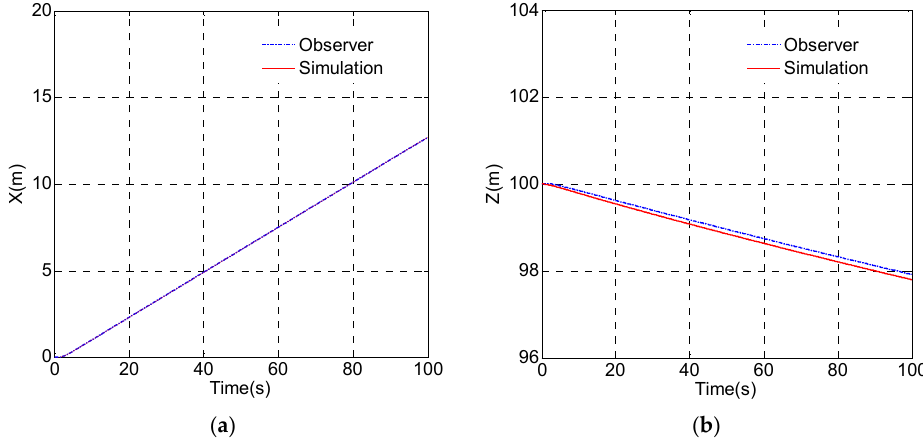
Figure 19. Observed result of ROV position: ( a ) position in the X direction; ( b ) position in the Z direction. Appl. Sci. 2018 , 1, x FOR PEER REVIEW